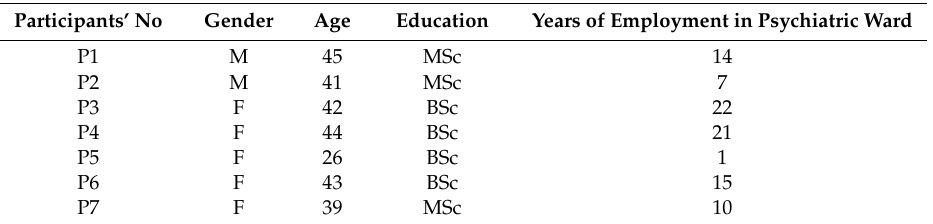
Table 1. Demographic data of study